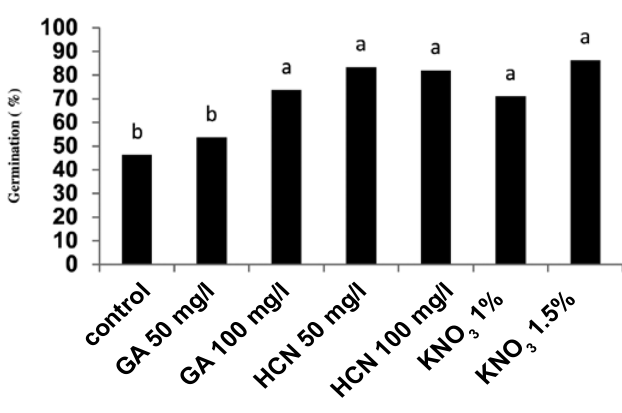
variety.Fig. 5 - Effect of different priming agents on cumulative germination percentage (G ) of Abbasali pistachio max